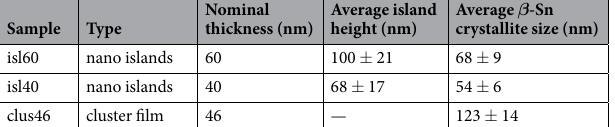
Table 1. Characteristics of the investigated samples. For the island samples, the thickness refers to the nominal thickness of Sn (amount of material) deposited on Si(111). For the cluster-assembled film, the thickness is